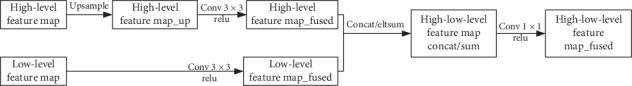
Fusion module a.